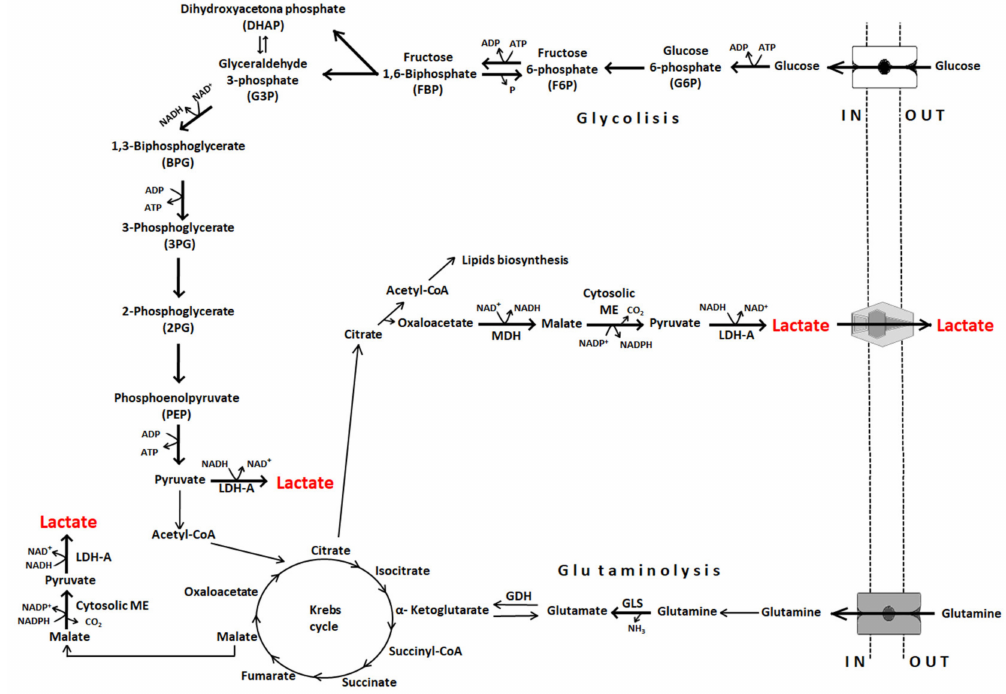
Figure 1. The main biochemical pathways implicated in cancer cell lactate generation. ME, malic enzyme; MDH, malate dehydrogenase; LDH-A, lactate dehydrogenase A; GLS, glutaminase; GDH, glutamate